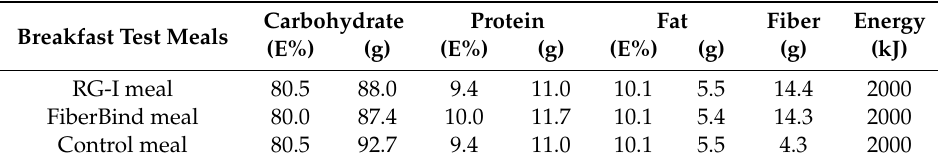
Table 2. Composition of the breakfast test